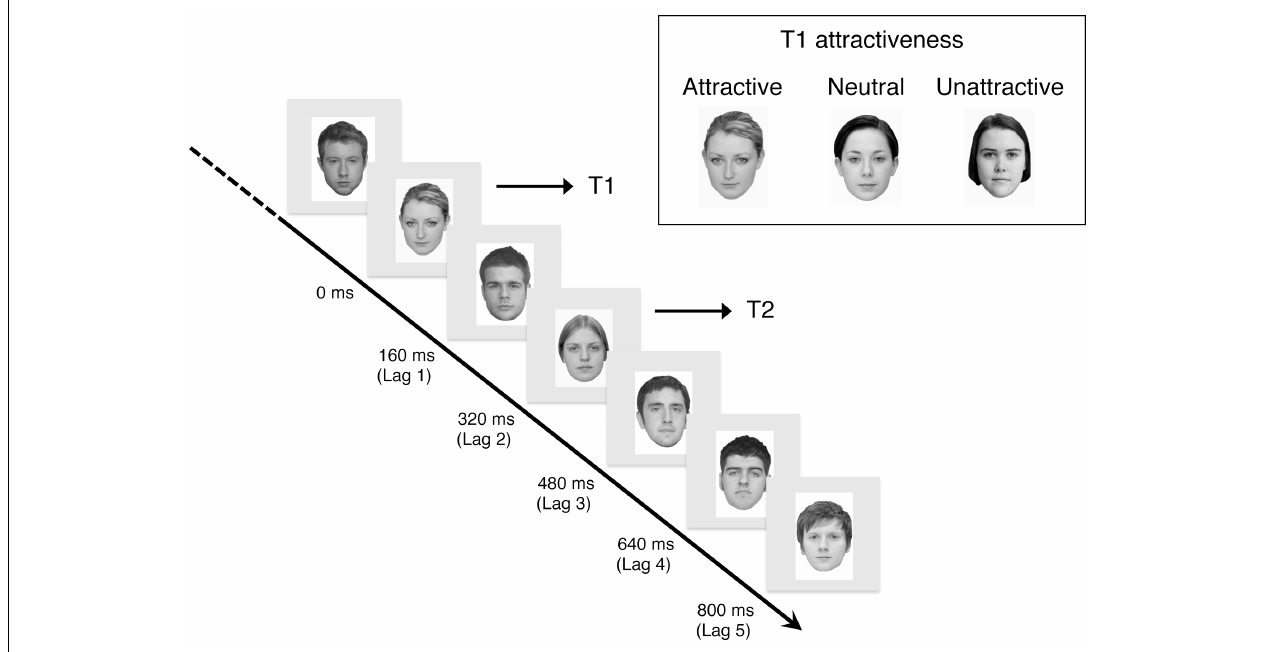
FIGURE 1 | Schematic diagram of dtRSVP task. Note thatT1 were attractive, neutral, or unattractive faces, whileT2 were always neutral at 320, 640, and 800 ms time lags.